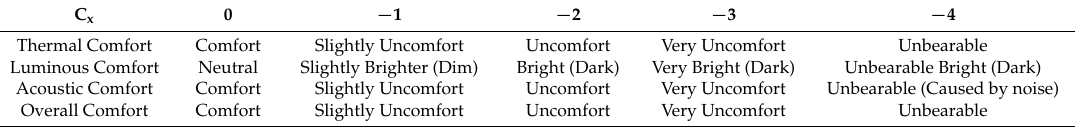
Table 1. The evaluation index of thermal environment, luminous environment, acoustic environment, and overall environment correspond to the comfort of physical stimulation. C x 0 Thermal